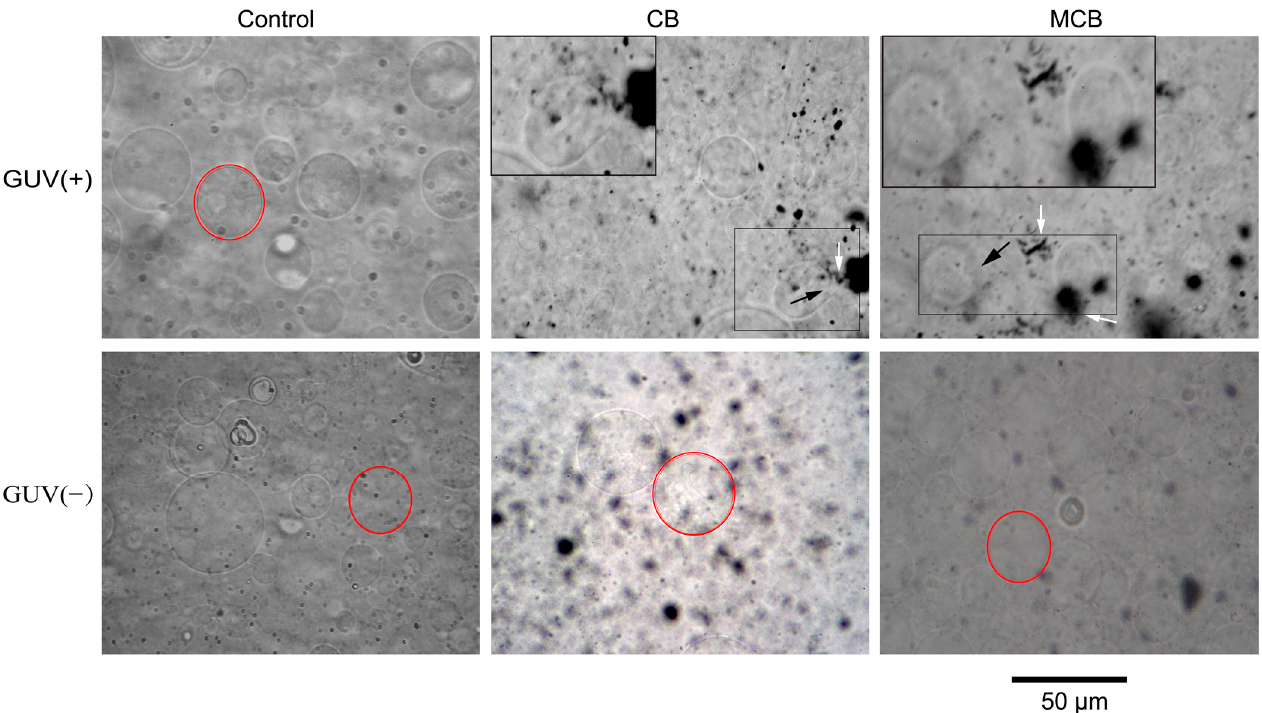
Figure 4. Microscopic images of GUV + exposed for 1 h and GUV − exposed for 12 h in low- concentration CB and MCB suspension. Inserts, magnified views of boxed areas. Red false color lines added to highlight the intact lipid bilayer. Black arrow indicates the deformed GUV. White arrow indicates the phospholipid fragments extracted by